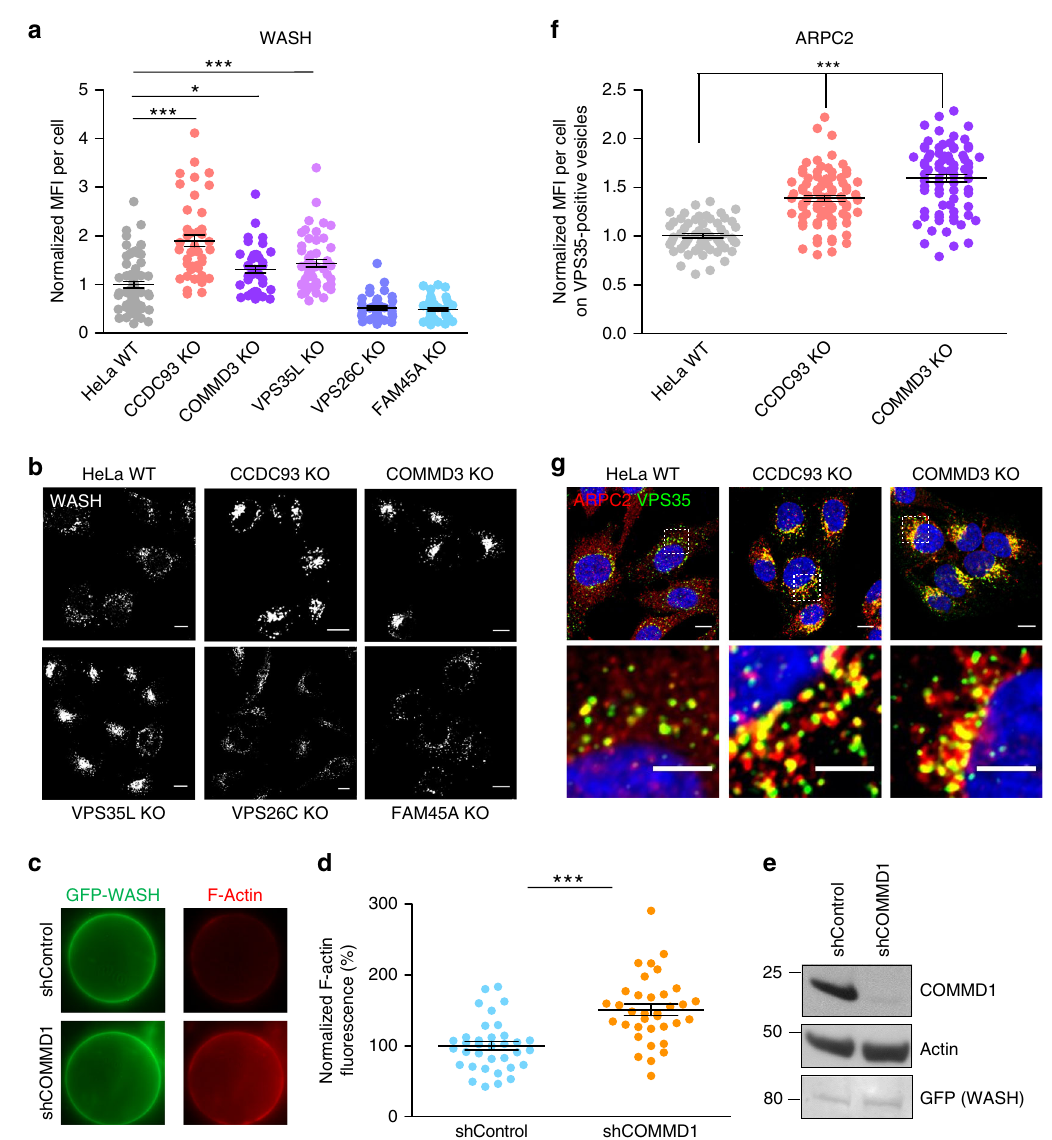
Fig. 4 WASH endosomal recruitment and activity are increased in CCC-de fi cient cells. a Normalized mean fl uorescence intensity (MFI) of WASH was quanti fi ed in the indicated cell lines. Results for individual cells are plotted, along with the mean and s.e.m. for each group ( n = 62 cells for HeLa WT, 45 for CCDC93 KO, 48 for COMMD3 KO, 50 for VPS35L KO, 43 for VPS26C KO, 48 for FAM45A KO); *** P < 0.0001; * P < 0.05 (one-way ANOVA and Dunnett ’ s test to control). b Confocal imaging of WASH immuno fl uorescence staining in the indicated cell lines, corresponding to a . Representative images are shown from two independent experiments. Scale bars, 10 μ m. c WASH complex activity was determined by pyrene-actin assembly assays in the indicated cell lines ( Wash knockout fi broblasts reconstituted with HA-GFP-WASH, that were further transduced with shControl or shCommd1 lentiviruses). WASH recovery and F-actin deposition on protein G beads was determined by fl uorescence microscopy (examples shown on the left panels). d Quanti fi cation of F-actin fl uorescence, normalized to WASH recovery is shown (middle panel), with mean values and s.e.m. plotted ( n = 35 cells); *** P < 0.0001 (unpaired two-tailed t test to control). e Immunoblot analysis of the two cell lines is also shown (right panel), including Commd1, WASH